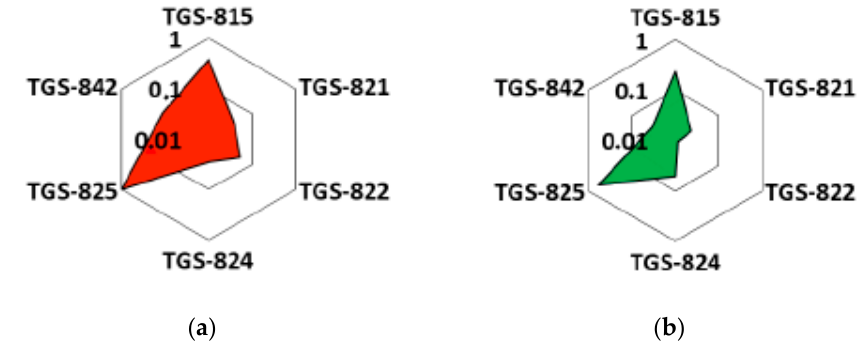
Figure 5. Sensor electrical conductance changes in the presence of ( a ) okoume, ( b ) aiele essential oils using an electronic nose system.